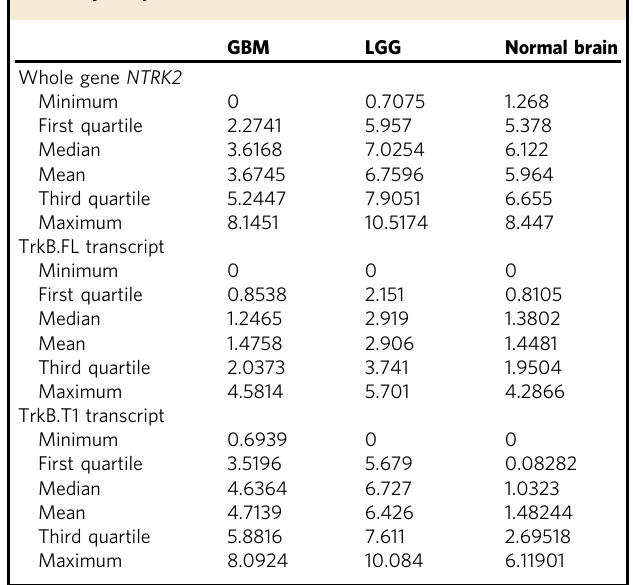
Fig. 1 Gene expression differences in human normal brain and human glioma. a Principal component analysis (PCA) plot of all brain samples from Genotype- Tissue Expression (GTEx) project. Samples from 13 regions fall into two groups clearly separating the cerebellum samples from the rest of the brain regions. b Principal Component analysis (PCA) plot of pooled brain samples from GTEx (with cerebellum and spinal cord removed) and The Cancer Genome Atlas (TCGA) samples using gene expression from 20,214 genes from hg19. Two clear clusters were formed, TCGA-GBM and TCGA-LGG samples fall into one cluster while the supratentorial regions from GTEx maintain the one pooled normal brain cluster from a . c PCA plot of pooled normal brain regions broken down shows minimal regional speci fi city and clustering based on 20,214 genes from hg19. d PCA plot showing tumor samples from TCGA using gene expression of 20,214 genes in hg19 colored by CpG Island Methylation Phenotype (CIMP) status. CIMP and non-CIMP status for TCGA samples were obtained from Bolouri et al. 26 , and show distinct CIMP vs non-CIMP clusters based on total gene expression. Normal brain regions are displayed as circles, brain tumors are displayed as triangles. Table 2 log2(TPM) values for NTRK2 whole gene expression, TrkB.FL transcript expression, and TrkB.T1 transcript